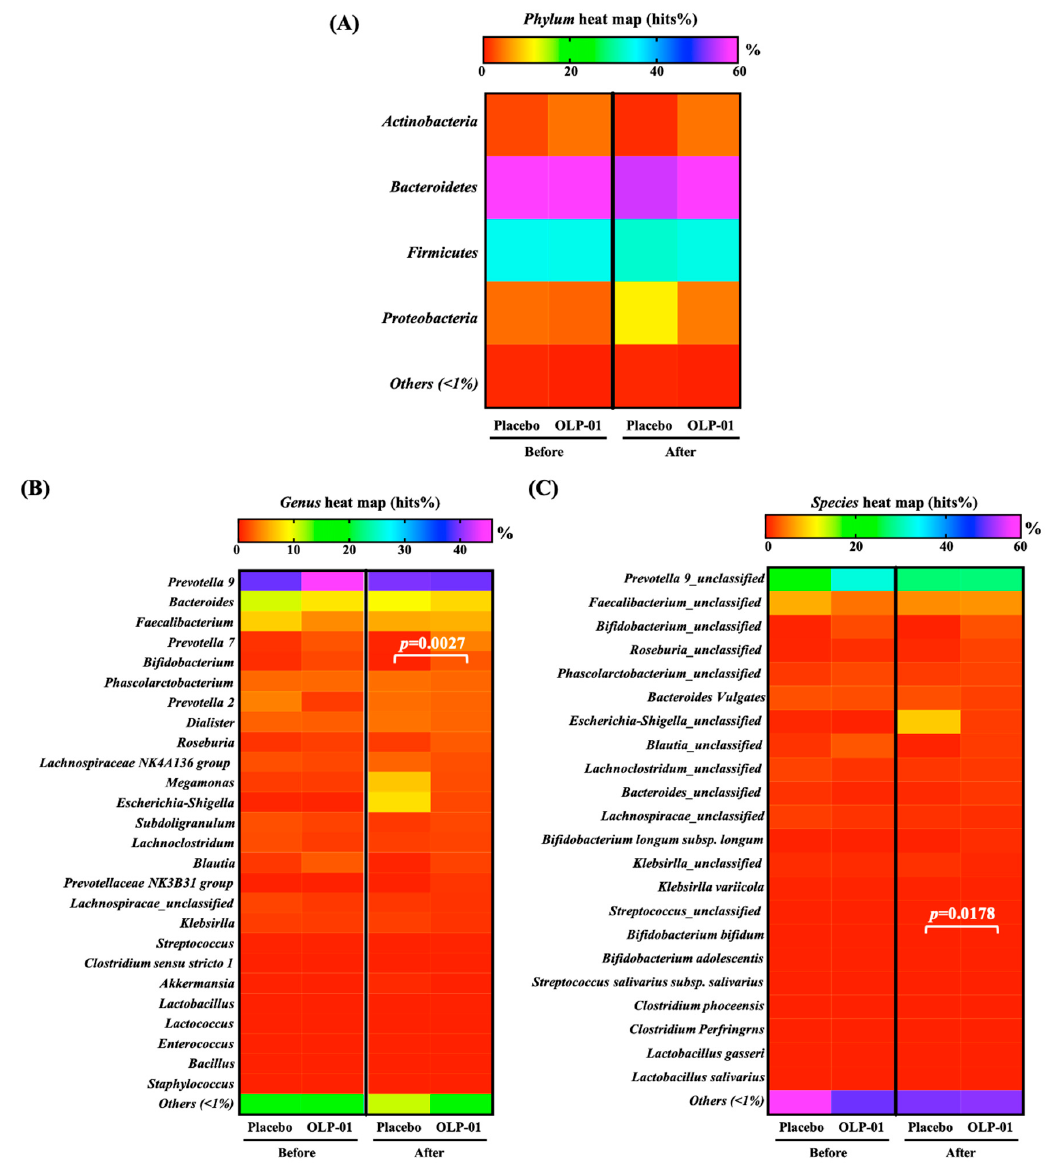
Figure 3. Gut microbiota heat map (hits%) of ( A ) Phylum , ( B ) Genus , and ( C ) Species . Data are expressed as mean ± SEM and indicate significant difference at p < 0.05.